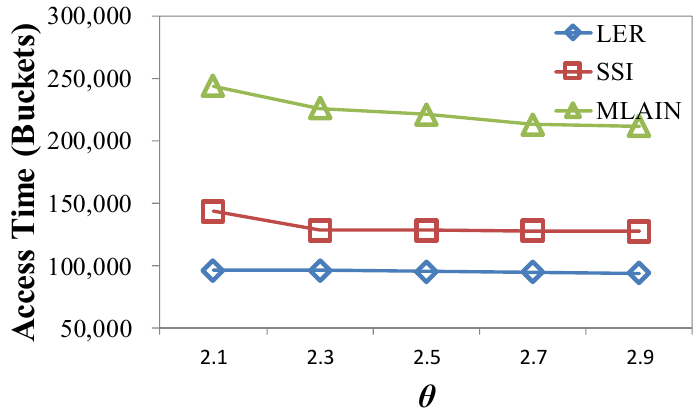
Figure 11. Average access time for changing θ values. Table 4. Average tuning time for changing of θ values.